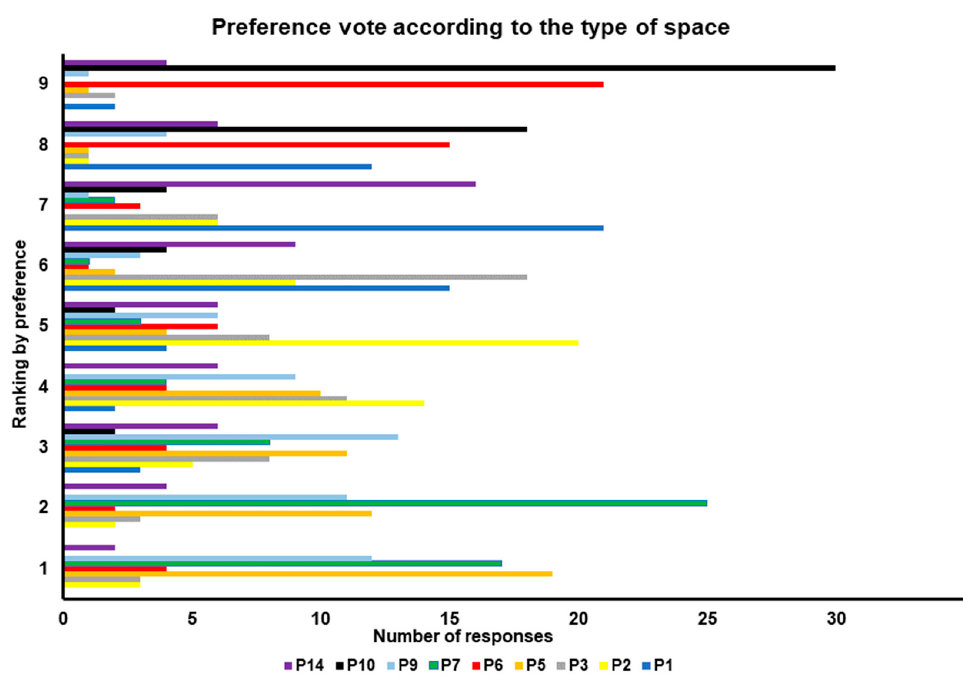
Figure 7. Users’ feeling of comfort according to the type of space in Casbah of Algiers.